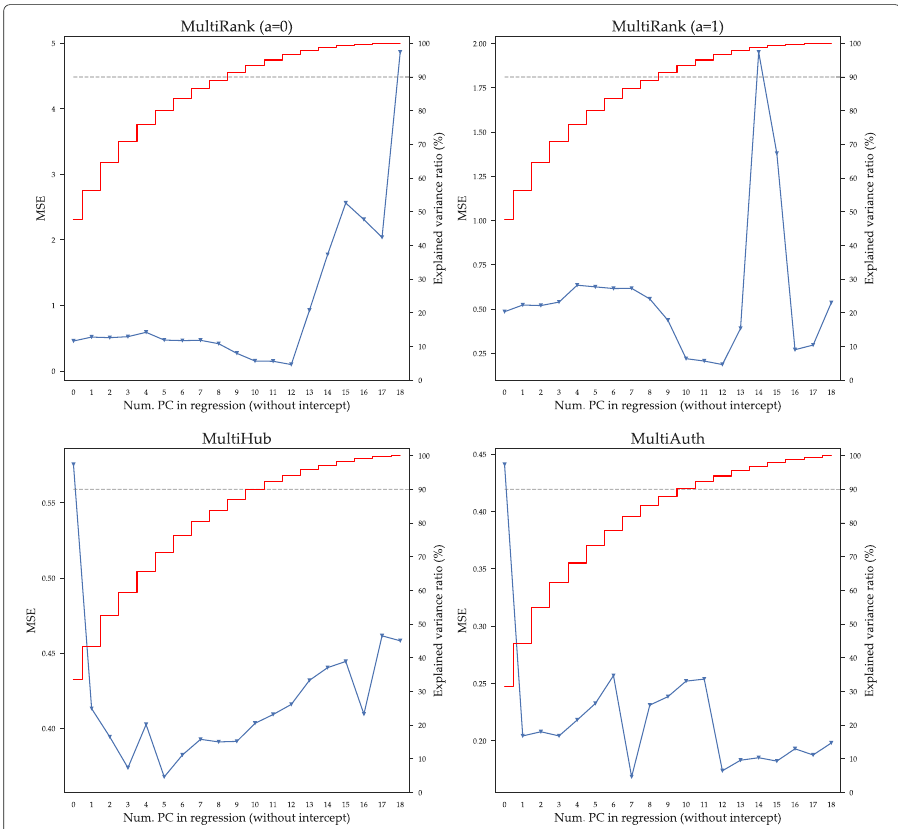
Fig. 4 In red: number of principal components sufficient to explain 90% of the variance of the measures of centrality calculated on the single layers (scale reported on the right y-axis). In blue: mean square error obtained by regressing the multilayer measures of centrality against the principal components of the single layer centralities, added one by one (scale reported on the left y-axis). All results refer to the cross section in 2003, results for the cross section 2010 are available in the